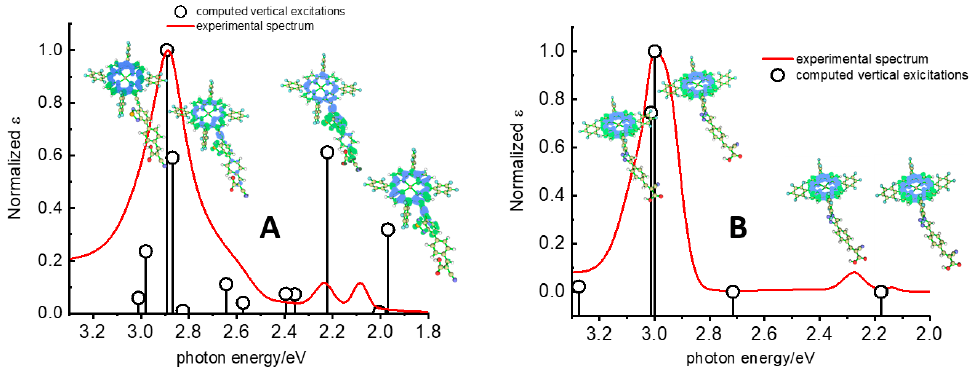
Figure 5. Computed vertical transitions at the TDDFT 6311 Gd,p level (black vertical bars) overlapped with the experimental spectrum. Vertical transitions were red shifted by 0.22 eV ( A ; 1 ) and 0.13 eV ( B ; 2 ) to match the Soret band maximum with the most intense vertical transition. EDDMs (isovalue 10 − 3 ) associated with the most intense transitions in Q and B band region are shown as insets. Increased electron density is indicated by a green surface, depleted electron density (i.e., a “hole”) is indicated by the blue surface.